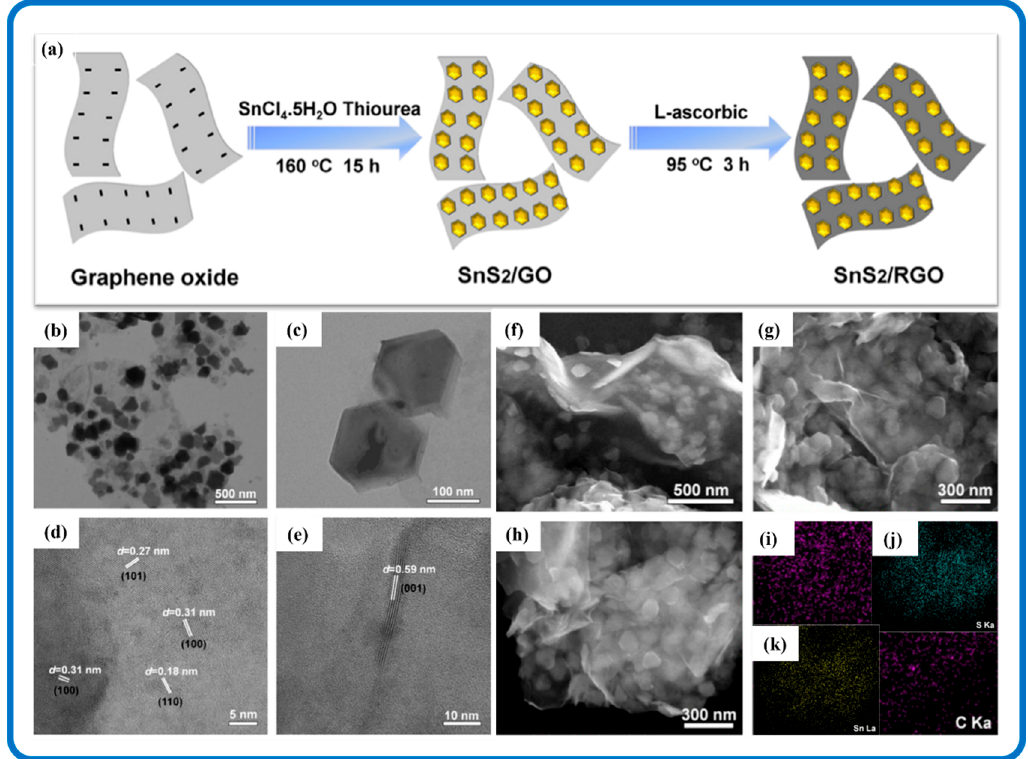
Figure 10. ( a ) Schematic illustration of the fabrication process for the SnS 2 /rGO composite, ( b , c ) TEM and ( d , e ) HRTEM images of the SnS 2 /rGO composite, ( f – h ) SEM images of the SnS 2 /rGO composite, and ( i – k ) the elemental mapping of C, S, and Sn, respectively, corresponding to ( h ). Adapted with permission from [165]. Copyright 2017, Elsevier.